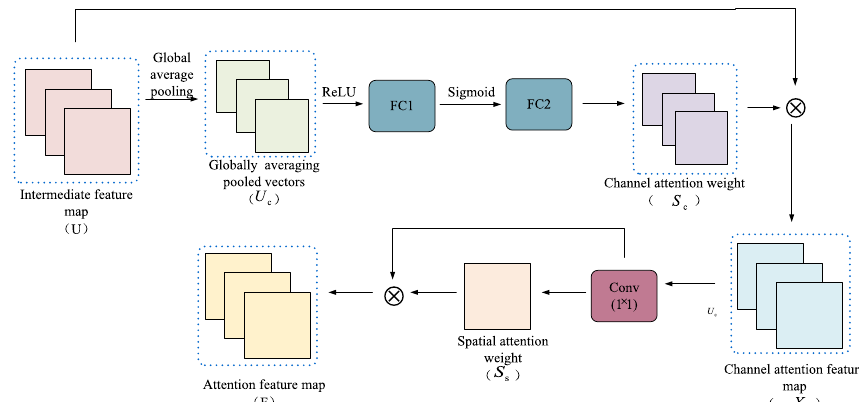
Fig. 3 The structure of the attention mechanism